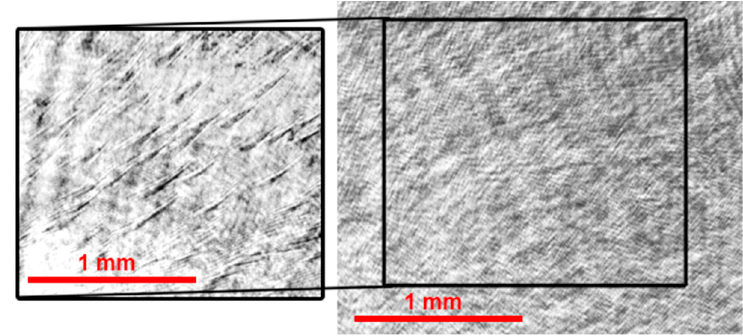
Figure 4. Hologram of the ZnGeP 2 plate with thickness of 6 mm cut parallel to the growth direction (on the right ) and restored image of the plate cross section containing a volume defects at a depth of 4.8 mm (on the left ).